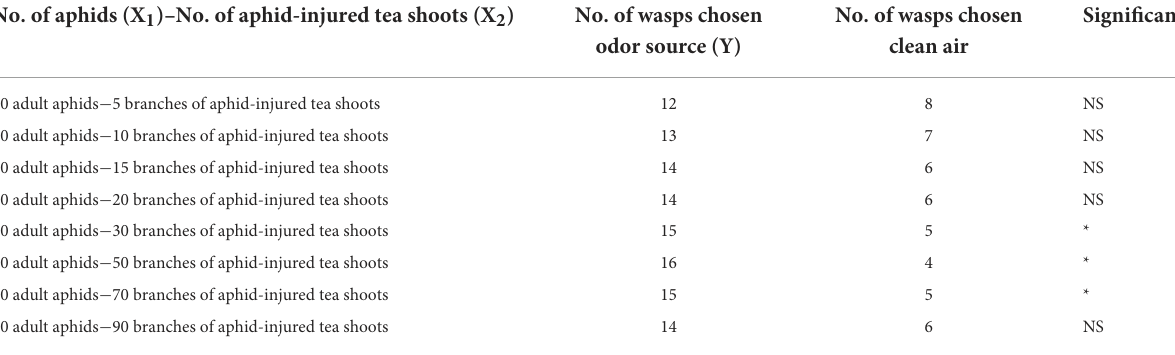
TABLE 2 Number of Aphelinus sp. attracted to tea shoot–aphid complexes vs. clean air in Y-tube olfactometer assay. No. of aphids (X 1 )–No. of aphid-injured tea shoots (X 2 )